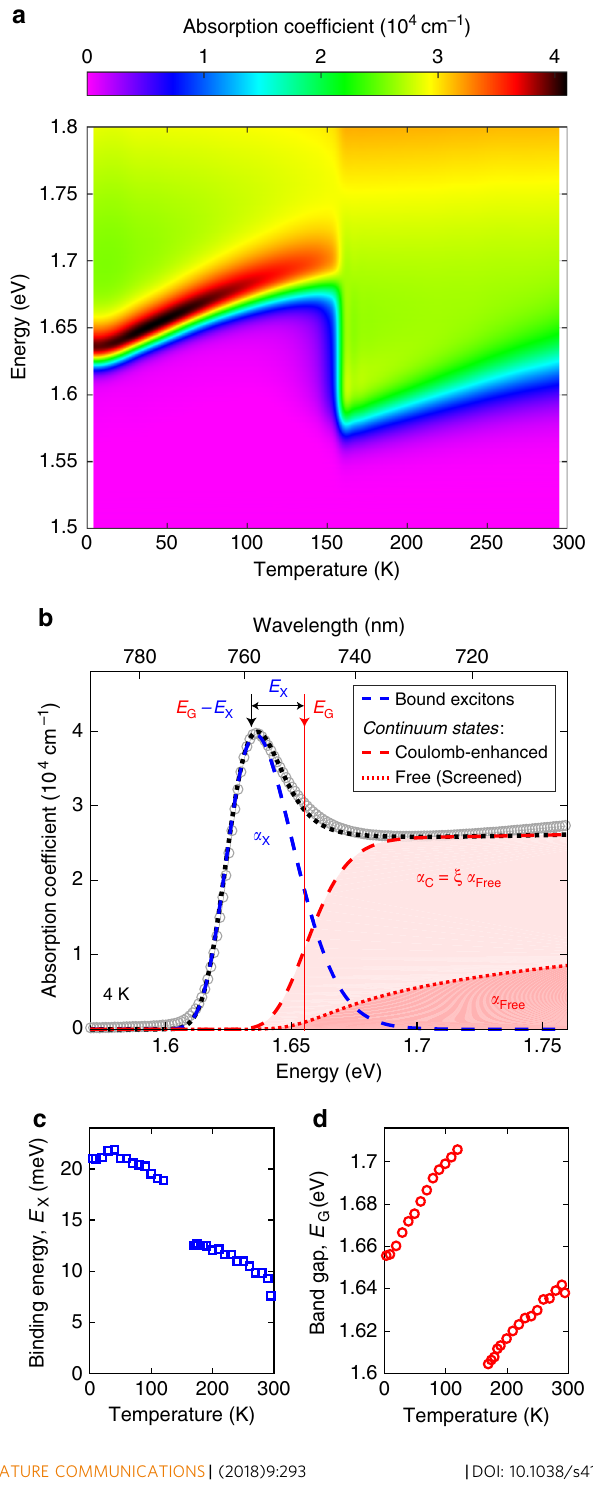
Fig. 1 Absorption modelling of CH 3 NH 3 PbI 3 . a Two-dimensional colour map of the absorption spectra of CH 3 NH 3 PbI 3 as a function of energy and temperature. b Absorption spectrum of CH 3 NH 3 PbI 3 taken at 4 K. The black dotted line is a fi t to the data based on Elliott ’ s theory as described in the main text, which allows the separation of the contributions to the total absorption coef fi cient arising from bound excitonic states ( α X , blue dashed line) and Coulomb-enhanced electron-hole continuum states ( α C , red dashed line), which is increased beyond the absorption from free (screened) electrons and holes ( α Free , red dotted line) by the Coulomb- enhancement factor ξ . Arrows indicate the position of the band gap ( E G ) and the value of the exciton binding energy ( E X ). c Exciton binding energy and d band gap energy of CH 3 NH 3 PbI 3 as a function of temperature, obtained from fi ts based on Elliott ’ s theory to the band-edge absorption data shown in Figure S3 in Supplementary Information. The small gap in displayed points between 140 and 170 K is owing to the coexistence of